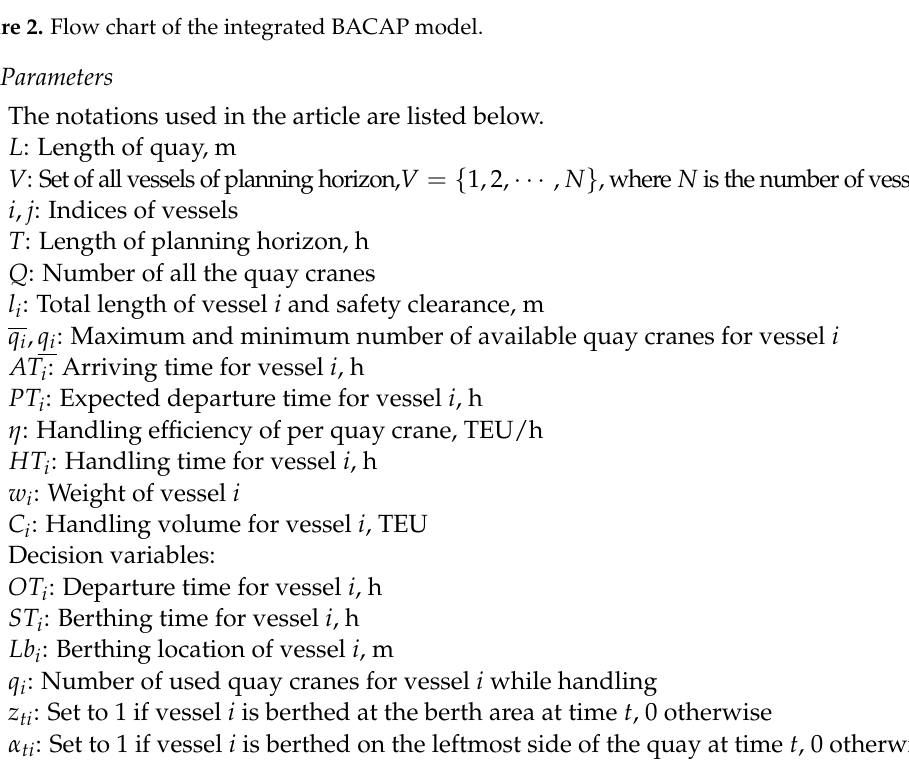
Figure 2. Flow chart of the integrated BACAP model.